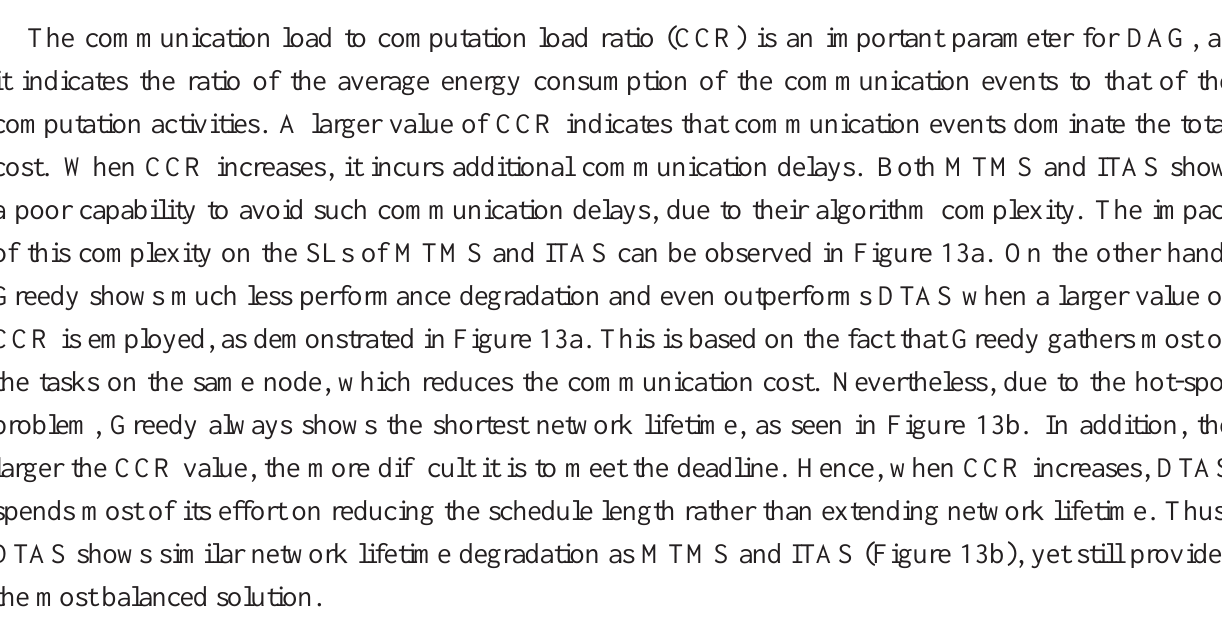
Figure 13. The effect of communication load to computation load ratio (CCR). ( a ) Average SL; ( b ) Average